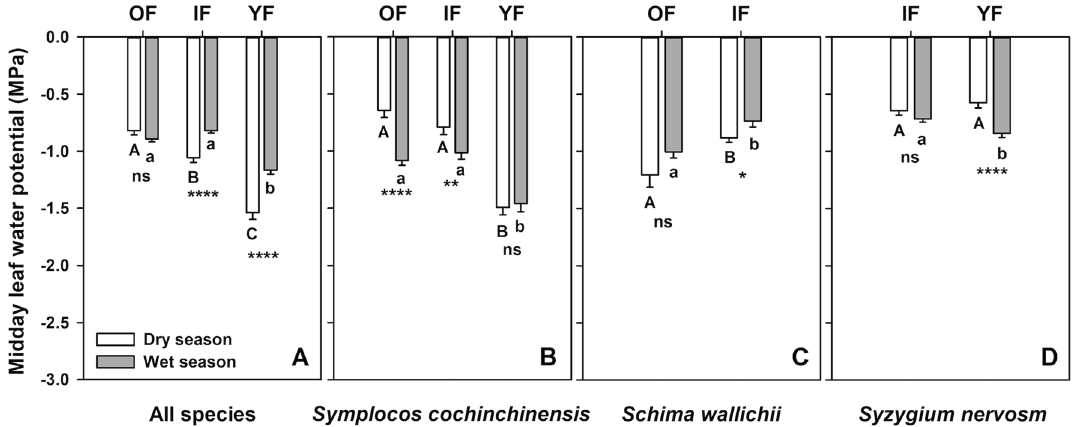
Figure 2. Midday leaf water potential (Ψ md ) from the old-growth (OF), intermediate (IF) and young (YF) forests during the dry (white bars) and wet (gray bars) season in ( A ) all species and those growing in multiple successions including ( B ) Symplocos cochinchinensis, ( C ) Schima wallichii and ( D ) Syzygium nervosum. Each bar represents mean ± one standard error of 150 sampled leaves in ( A ), and 30 samples in ( B–D ). For each panel, different upper- and lower-case letters represent significant differences in the wet and dry seasons, respectively. Asterisks indicate significant seasonal differences within the same successional stage based on independent sample t-test .; ns = not significant, * p < 0.05, ** p < 0.01, *** p < 0.001, and **** p < 0.0001.